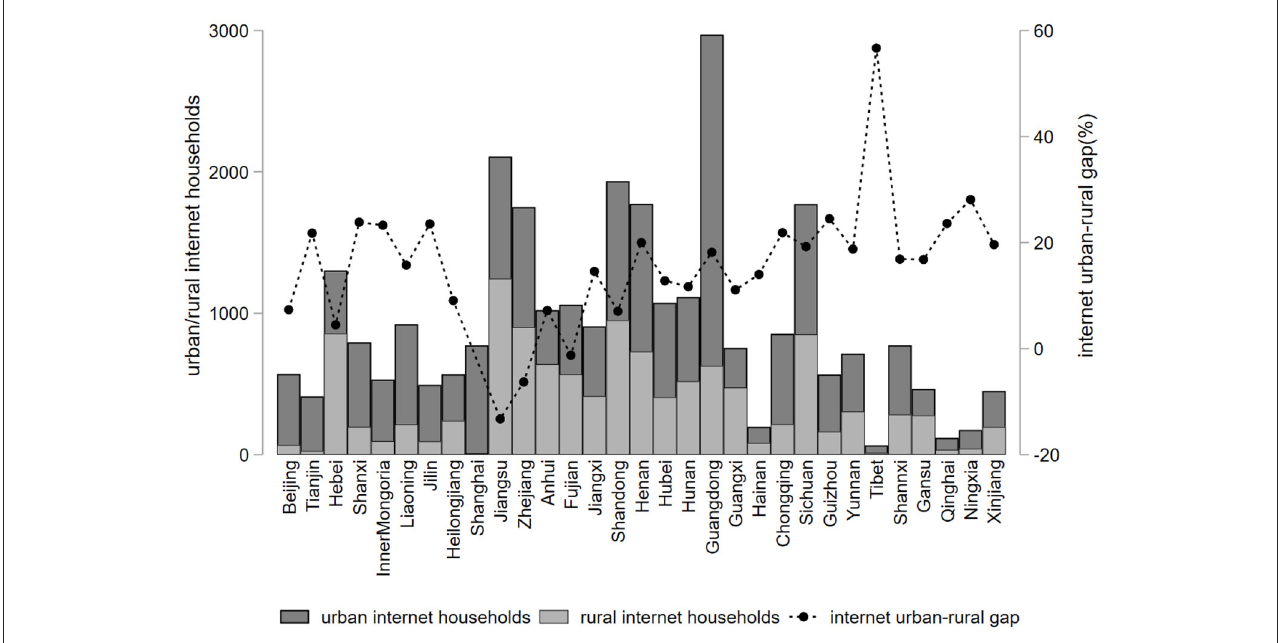
FIGURE3 Urban-rural differences on the Internet by province,